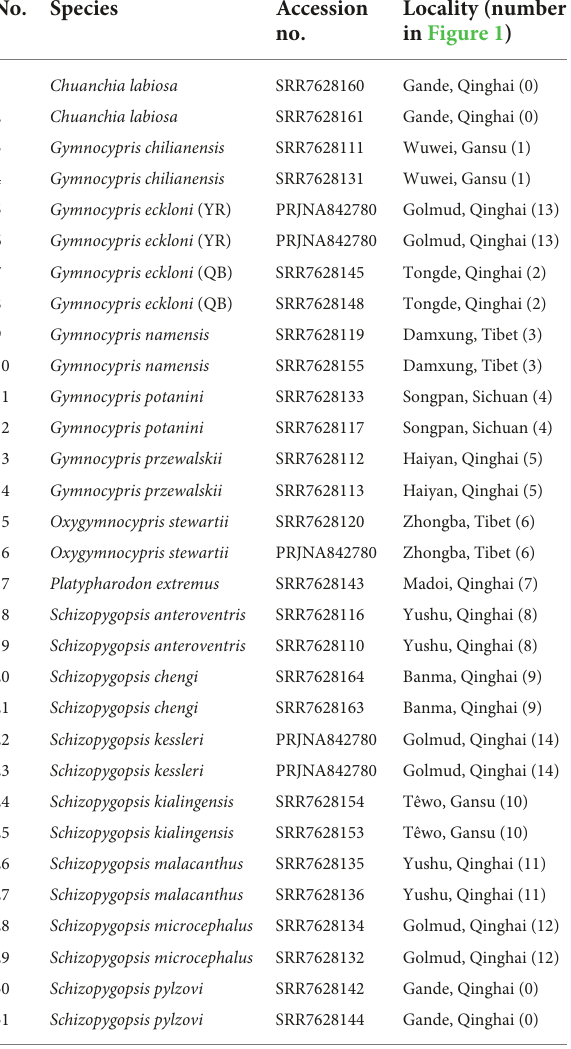
TABLE 1 Taxonomic information, sampling sites, and GenBank accession numbers of all species used in phylogenetic analysis. No. Species Accession